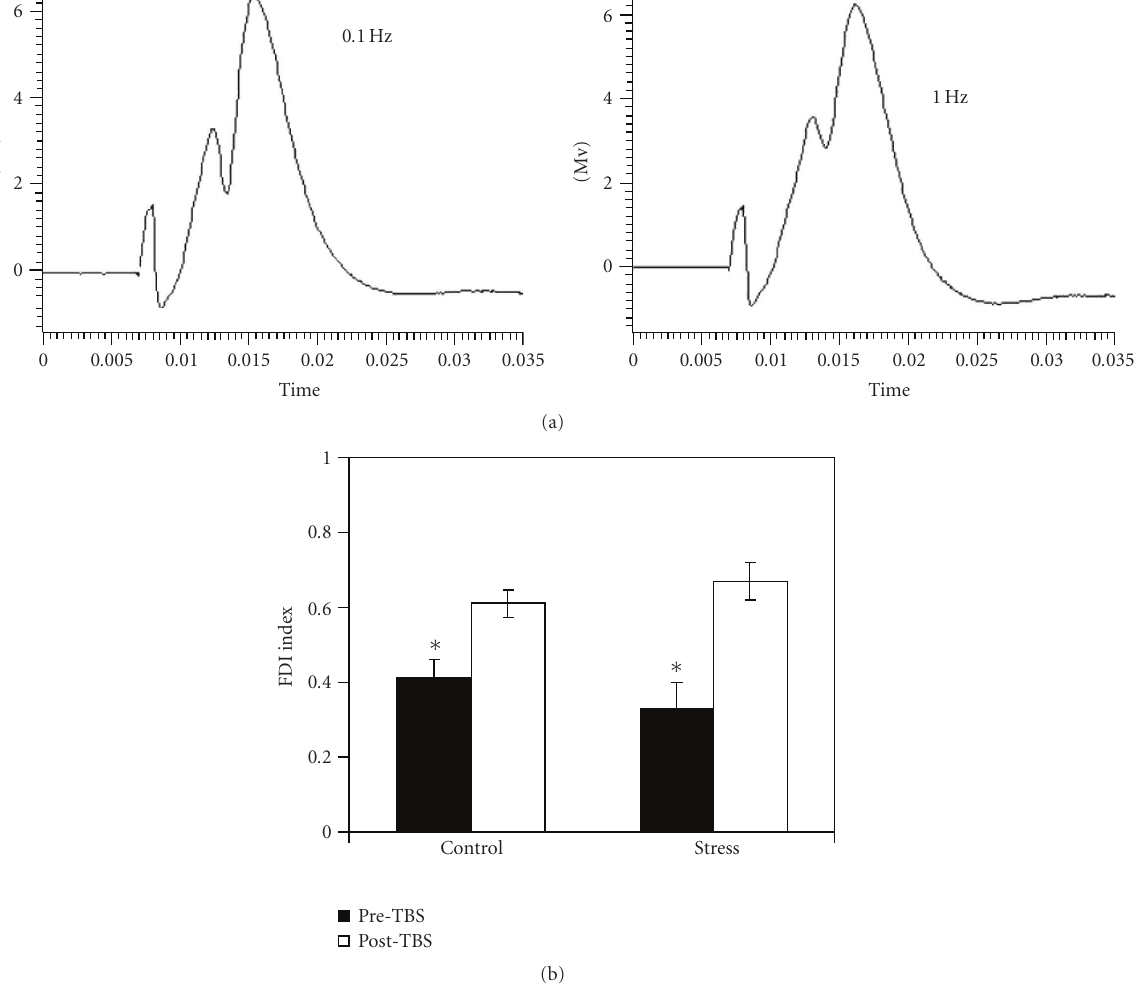
Figure 2: (a) Left: representative field potential response of dentate gyrus granule cells to stimulating of the PP at 0.1Hz. Right: representative field potential response of dentate gyrus granule cells to stimulation of the PP at 1.0 Hz. Time unit: second. (b) FDI before and after TBS application . The application of TBS significantly reduced FDI in both control ( n = 8) and stressed ( n = 8) rats ( P <